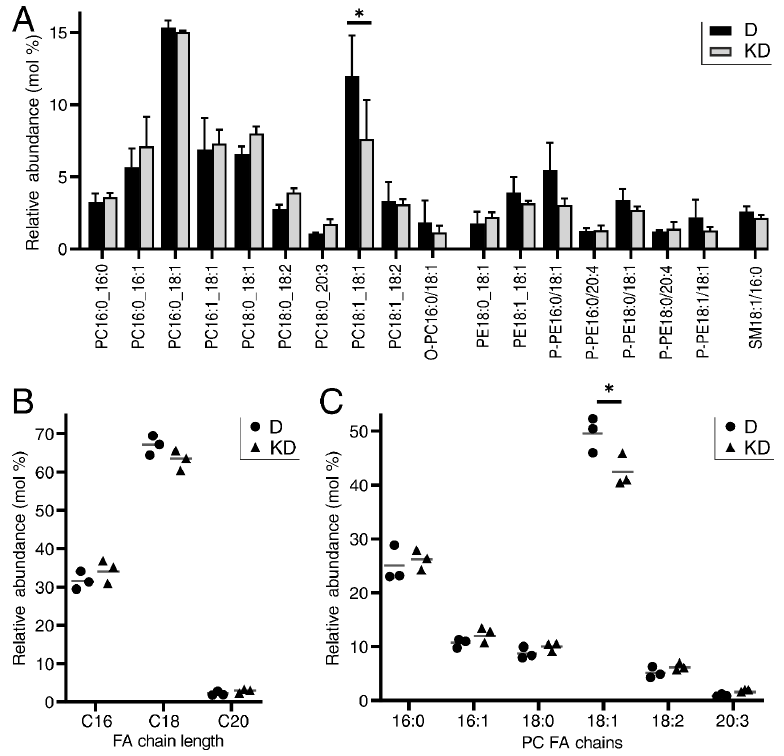
Figure 4. Impact of LPCAT4 knockdown [KD] on the lipidomic profile of in vitro differentiated [D] human urothelial cells. ( A ) LC-MS/MS negative ion profile of lipid species with an average propor- tion ≥1% in either condition, highlighting the only significant difference in PC 18:1_18:1 molecules. Bars represent average relative proportion across 3 NHU transduced donor backgrounds (donors 1, 3 and 4; Figure 3) with statistical comparisons based on paired post hoc Tukey’s tests from an orig- inal 2-way ANOVA with BH-corrected significance values. ( B ) Glycerophospholipid fatty acyl chain length does not show significant differences upon knockdown, but monounsaturated C18 use in PC is significantly reduced upon LPCAT4 knockdown ( C ). In ( B , C ), grey horizontal lines represent the average of 3 independent NHU donor backgrounds. Significance values were generated by paired ‘ t ’ tests, with * indicatin g p < 0.05.